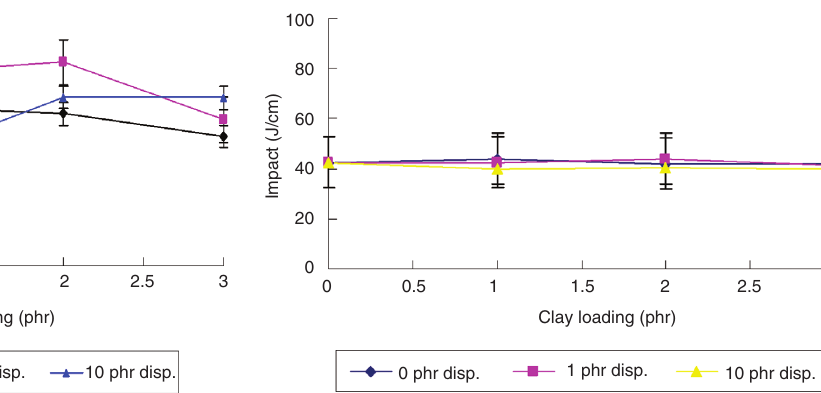
Figure 5 Tensile strength as a function of clay loading. Figure 7 Impact strength as a function of clay